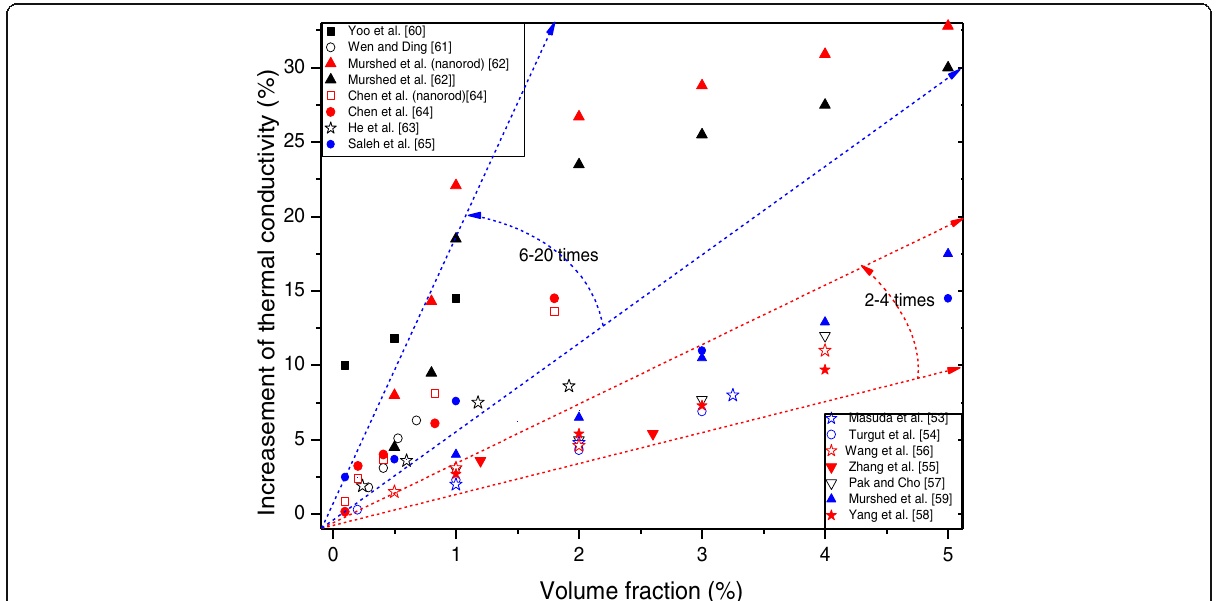
Fig. 1 Volume fraction dependence of thermal conductivity of TiO 2 – water nanofluids in available